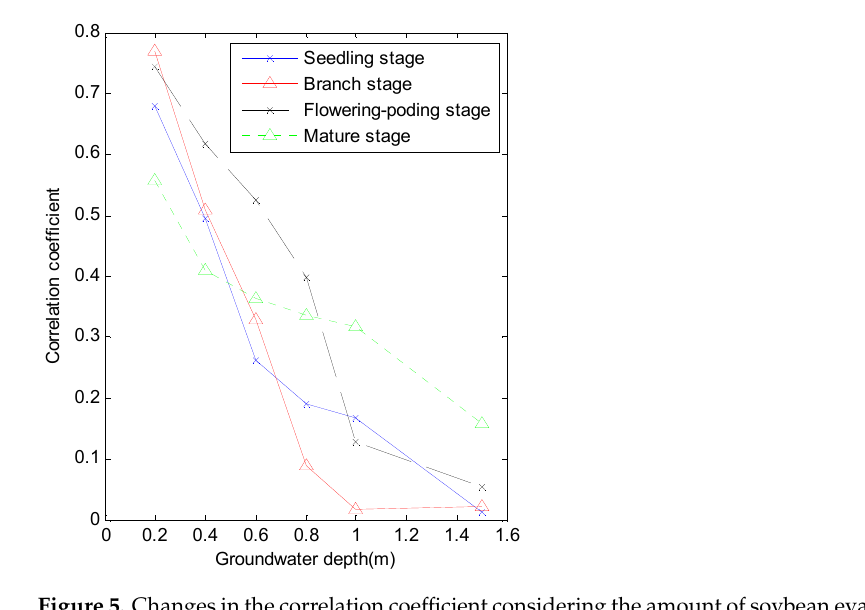
Figure 5. Changes in the correlation coefficient considering the amount of soybean evapotranspiration and groundwater contribution along with depth in different growth